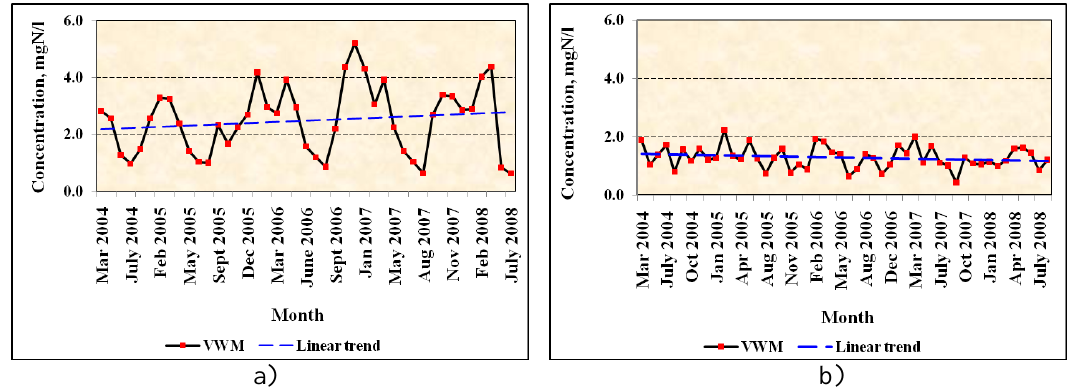
Figure 2. Monthly volume-weighted mean IFN concentrations in atmospheric precipitations in Sevastopol (a) and Katsiveli (b)